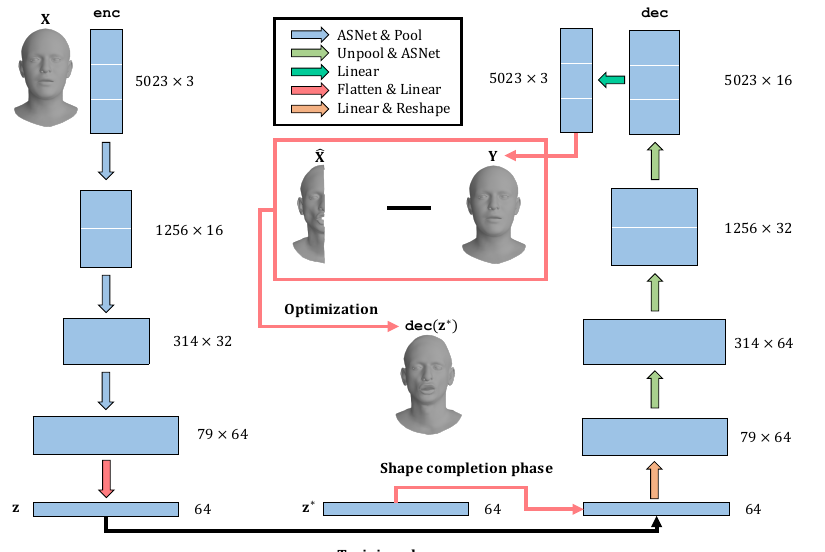
Figure 1. The architecture of the proposed model is based on anisotropic filters for 3D shape comple- tion and denoising. In the prediction phase, we undertake partial shape completion, which iteratively optimizes the initial latent variable z by minimizing the errors between the valid parts of the input mesh and the corresponding predicted parts Y while holding the network parameters constant. The resulting output mesh Y ∗ = dec ( z ∗ ) is obtained by passing the optimal latent variable through a